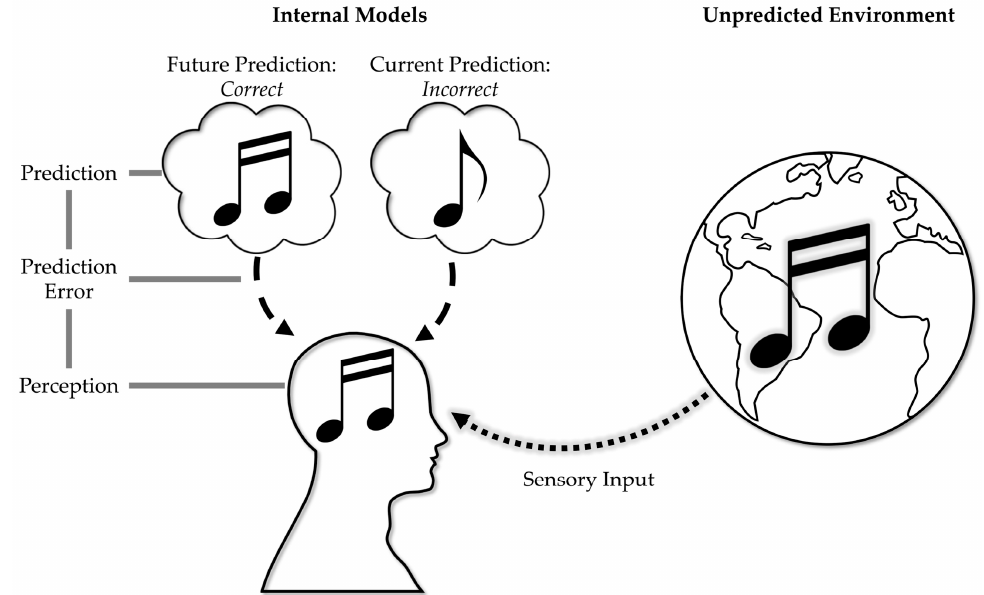
Figure 1. Bayesian perception. Bayesianism postulates that perception is a process of prediction (i.e., internal models, or prior; see figure left side) from incoming sensory input (i.e., from an unpredicted environment; see figure right side). Prediction error is the difference between current predictions and sensory input. If the sensory input does not fit with the prediction (i.e., prior), then the internal model updates (i.e., future prediction, posterior, which becomes new prior). Here, the current prediction is the song “White Christmas” by Bing Crosby. However, the sensory input is actually Los del Rio’s “Macarena Christmas,” which becomes the future prediction. (Figure inspired by [11]. Parts of figure modified and reproduced with permission from FlyClipart. CC BY-NC 4.0.).